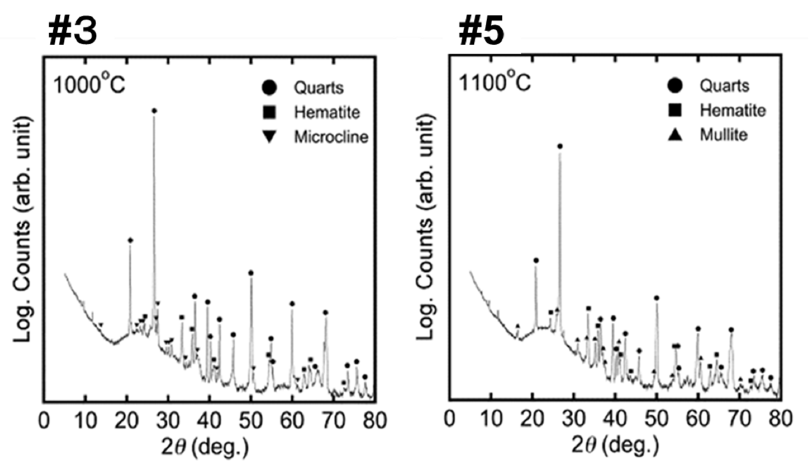
Figure 6. X-ray diffraction pattern of PSs (#3 and #5).